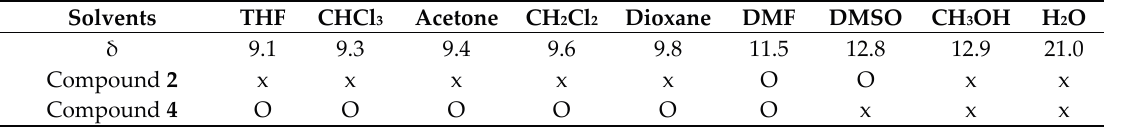
Table 1. Solubility of compounds 2 and 4 .